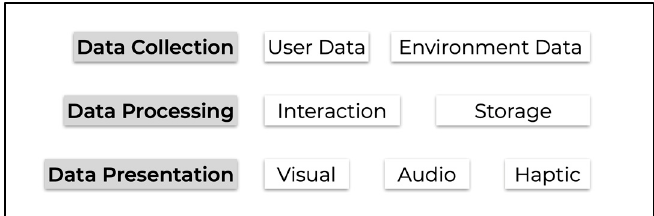
Figure 2. Meta ‐ characteristics for the taxonomy [27,28,29,30]. Figure 2. Meta-characteristics for the taxonomy